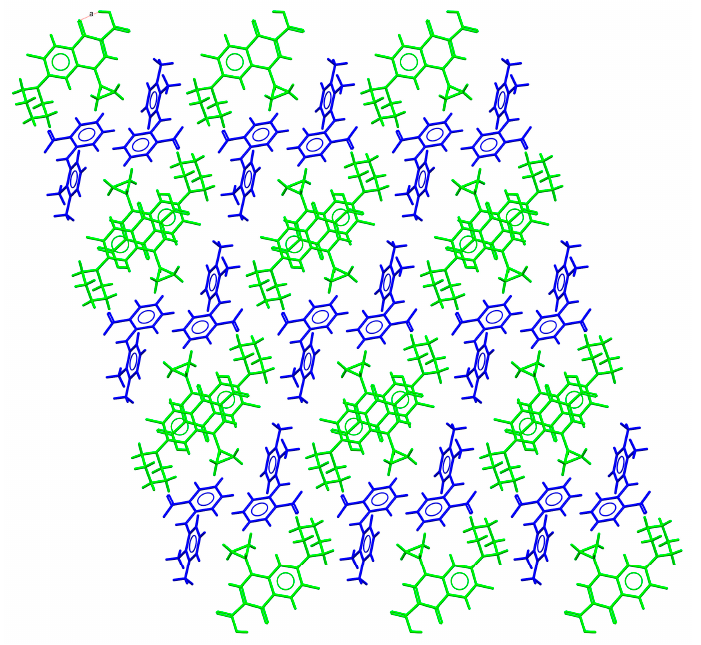
Figure 3. Detailed view of the packing arrangement of CIP cations (green) and MEF anions (blue) in the crystal structure of CIP–MEF.